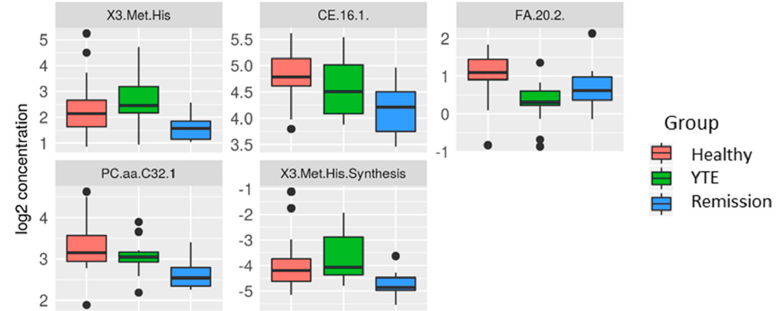
Figure 3. Box plots comparing metabolites after log-2 transformation in healthy controls, dogs with YTE, and dogs with YTE in clinical remission. Box Plots of metabolites with differences between clinically active YTE and YTE dogs in remission are shown. Box plots represent the 25–75th percentile; the median is shown as the heavy dark horizontal line. Vertical lines extend to the minimum and maximum values. Dots represent outliers. Legend: X3. Met. His, 3-Methionine-histidine; CE, ceramide; FA 20:2, eicosadienoic acid; PC, Phosphatidylcholine; YTE, Yorkshire Terrier enteropathy. YTE Remission Versus Healthy Controls